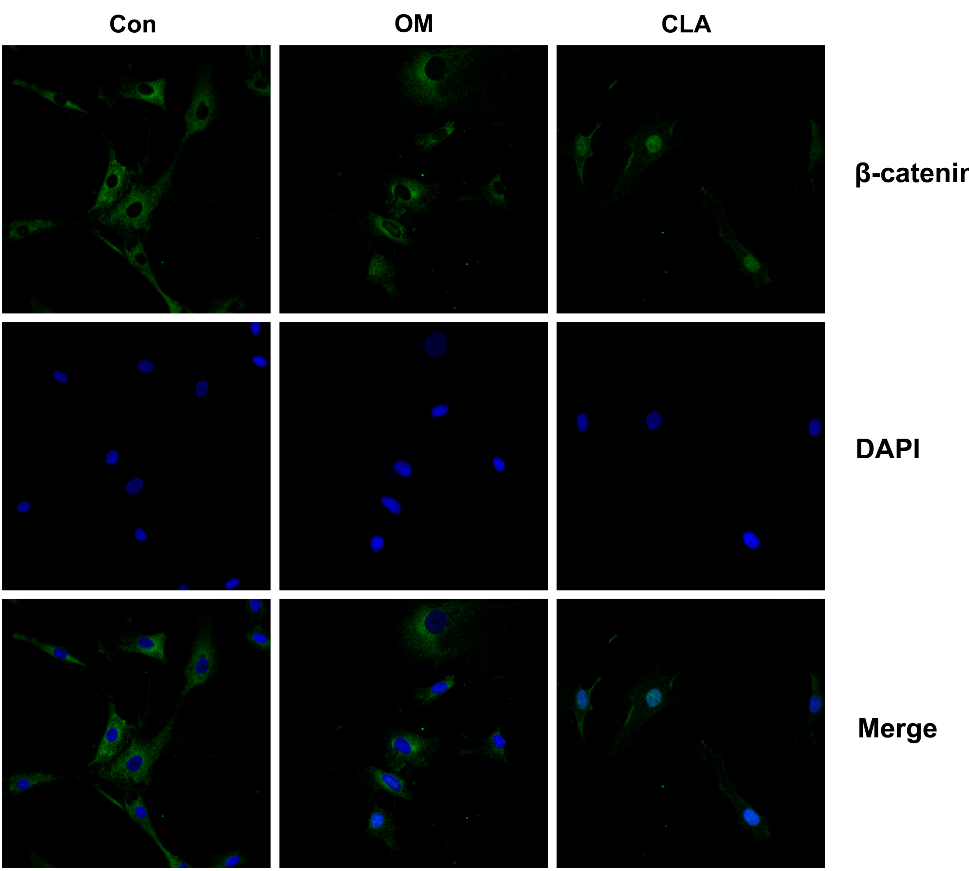
Figure 5. Confocal imaging for cellular β -catenin (100×). hBMSCs were maintained in growth medium (Con), or induced for osteoblast differentiation in the absence (OM) or presence of 1 μ M CLA (CLA) for 48 h. Cellular β -catenin (green) was detected by immunofluorescence staining, with the nuclei stained with DAPI (blue). In Con, β -catenin expressed mainly in cytosol. In CLA, β -catenin expressed mainly in nucleus.